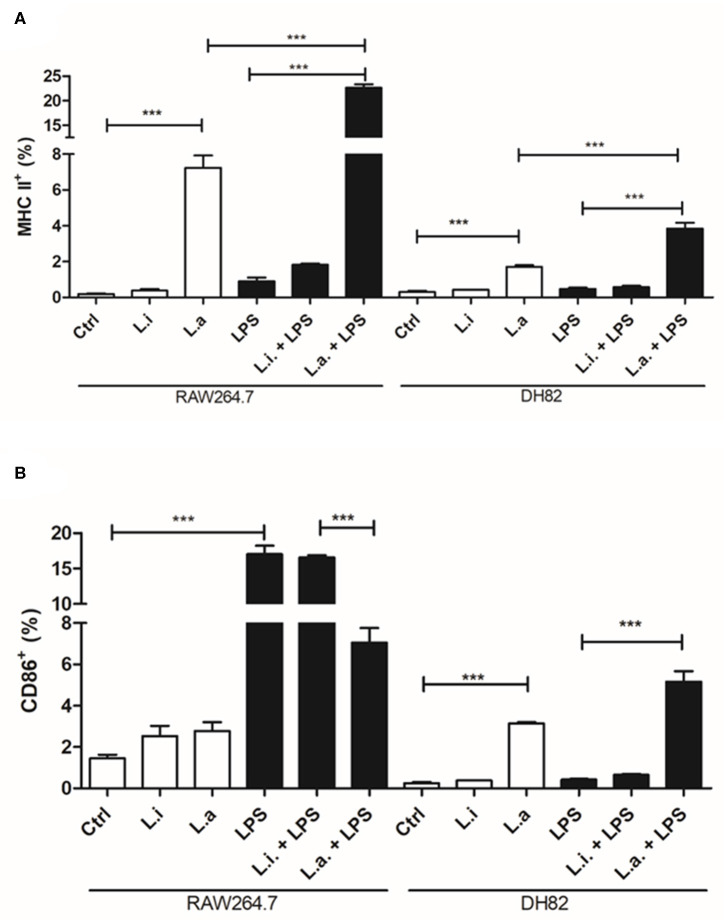
MHC and CD86 expression in canine DH82 and murine RAW264.7 macrophages. The cells (5 × 105/mL) infected or not with (Li.) L. infantum or (La.) L. amazonensis (5p:1m) were activated or not (Ctrl) with LPS [500 ng/mL] and maintained at 34 or 37°C/5% CO2. After 24 h post-infection, the cells were detached, stained for MHC (A) and CD86 (B) and analyzed by flow cytometry. Data from duplicate are expressed as mean ± SEM. ***p < 0.0001.